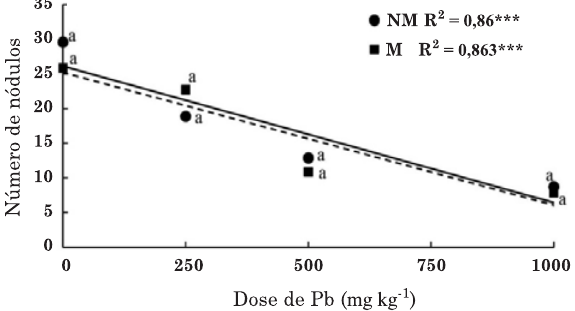
Figura 2. Formação de nódulos radiculares em raízes de plantas de Stizolobium aterrimum não micorrizadas (NM – linha contínua) e micorrizadas (M – linha tracejada) crescendo em solo contaminado com Pb. Letras iguais não di- ferem entre si pelo teste de Tukey a 5 % entre os tratamentos NM e M, dentro de cada dose de Pb. Significância: *** p <